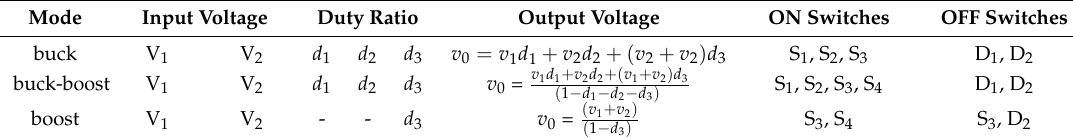
Table 2. Theoretical analysis of the proposed converter in buck, buck-boost and boost